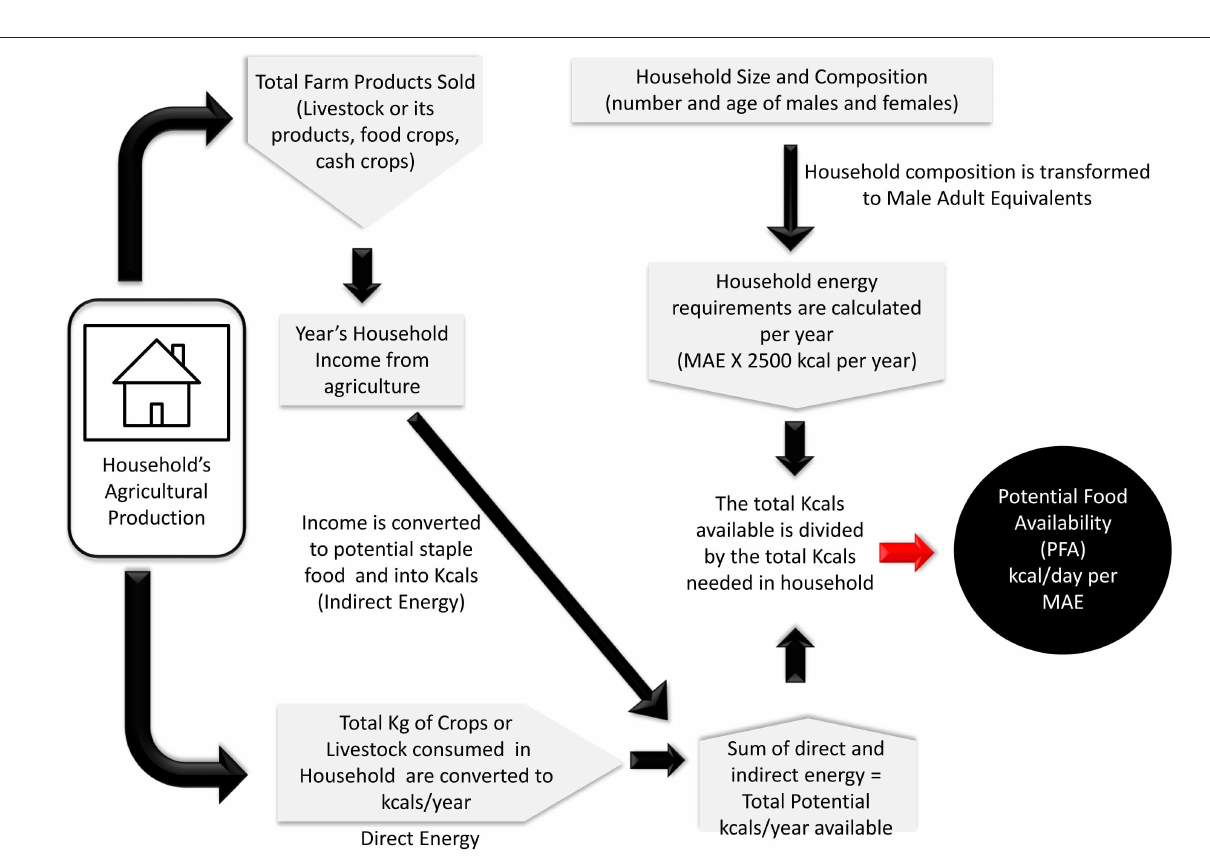
Frontiers in Sustainable Food Systems | www.frontiersin.org